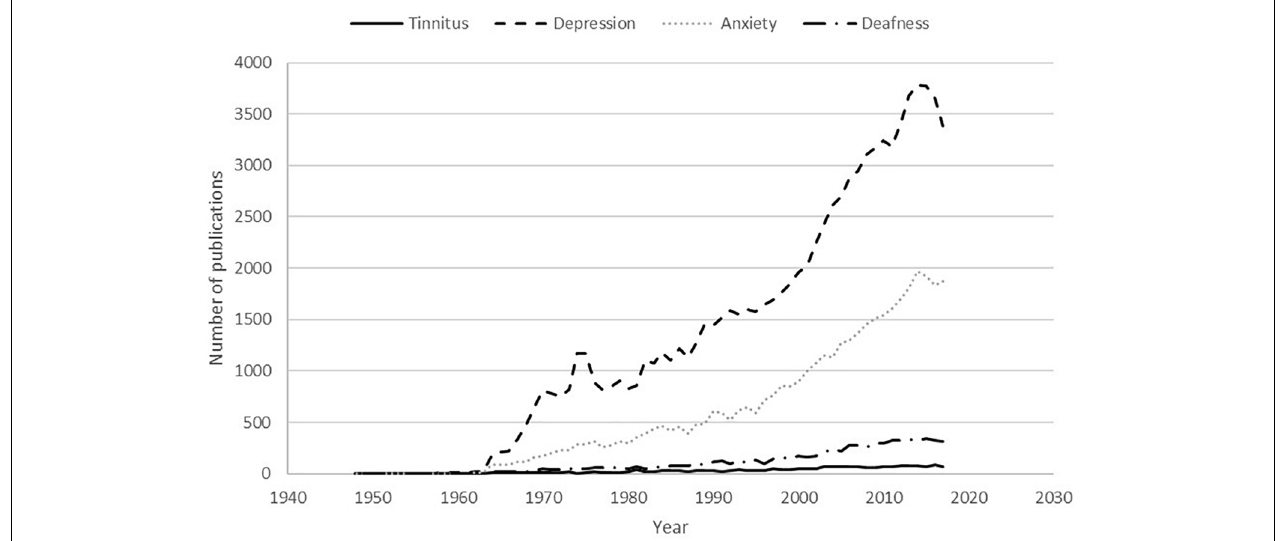
FIGURE 2 | Publications listed on the United States National Library of Medicine PubMed database for the search [(pharmacological treatment) OR (drug treatment)] AND condition (conditions: tinnitus, deafness, anxiety or depression) in the time period from 1940 to